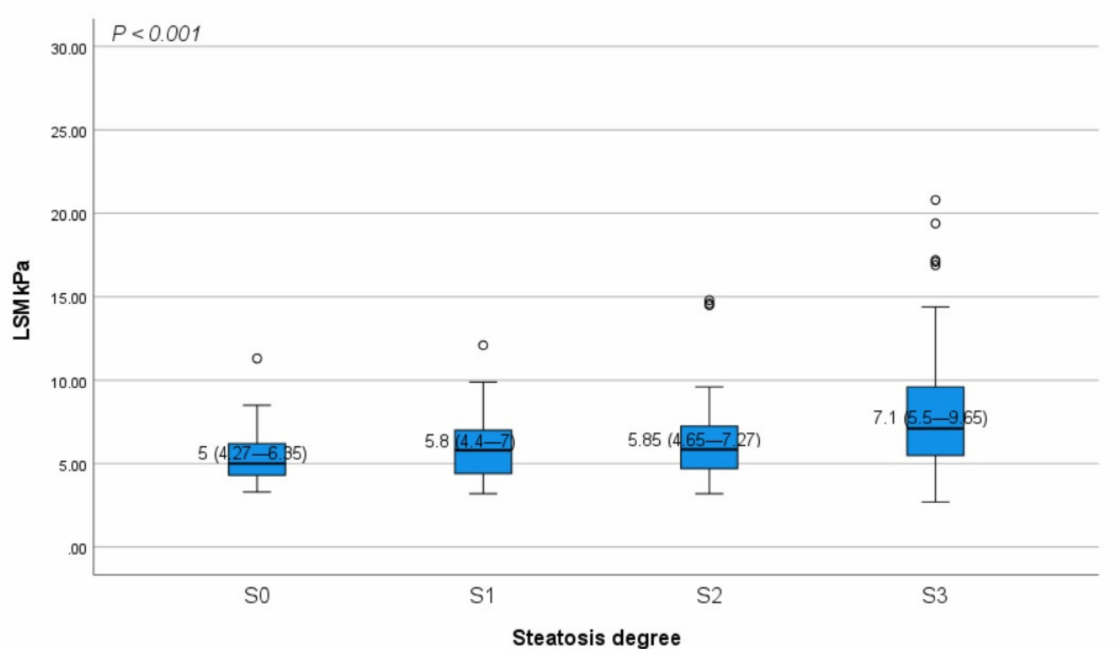
Figure 2. Distribution of LSM values according to steatosis degrees. The bottom and the top of each box represent the 25th and 75th percentiles, while the lines through the box indicate the median. The error bars indicate the 10th and 90th percentiles, excluding outliers (black circles). LSM, liver stiffness